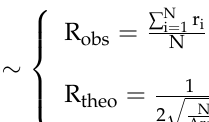
Figure 1. Tree map of the 3 groups of species for one of the 900 m 2 plots of the second experiment. A total of 10,696 trees were kept for the analysis. In order to deal with border effects, we used all border trees (i.e., those located within 1.5 m of the plot edges) as neighbours to calculate the distances between neighbours. These distances were also used to calculate the Clark and Evans index [6,47] (Equation (1)), which describes the aggregation of trees at the stand level. This index was calculated for each Gsp (R WS , R BF , and R HW ) and all trees (including saplings and merchantable trees) (Table 1). A value below 1 indicated a tendency to cluster, a value close to 1 as associated with a random distribution, and a value above 1 indicated a regular distribution.